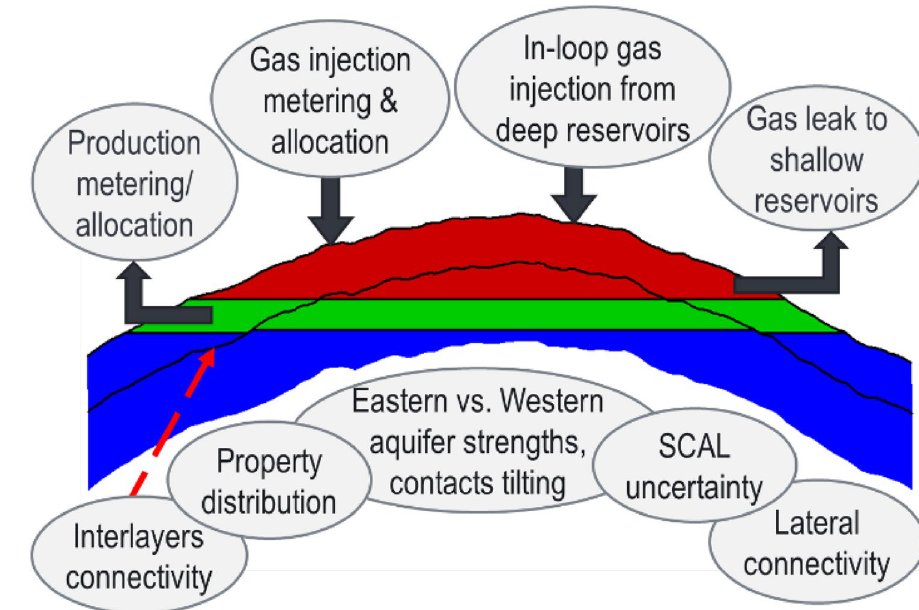
Fig. 9 Key uncertainties in XX– XY reservoir that have impact on history